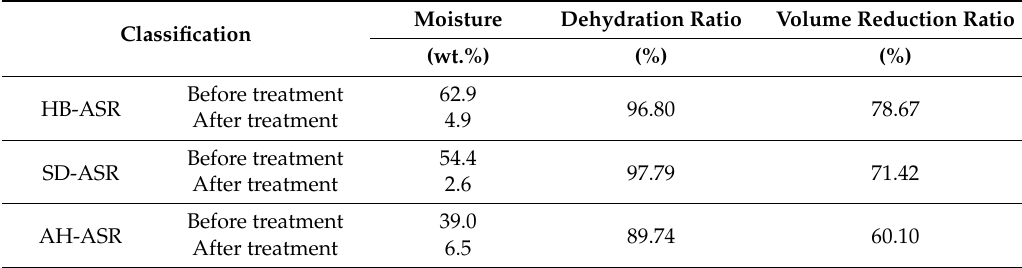
Table 3. The comparison of moisture, dehydration ratio and volume reduction ration for each ASR.